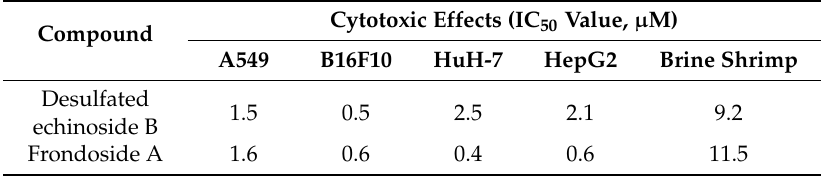
Table 3. Anti-proliferative effects of desulfated echinoside B and frondoside A.